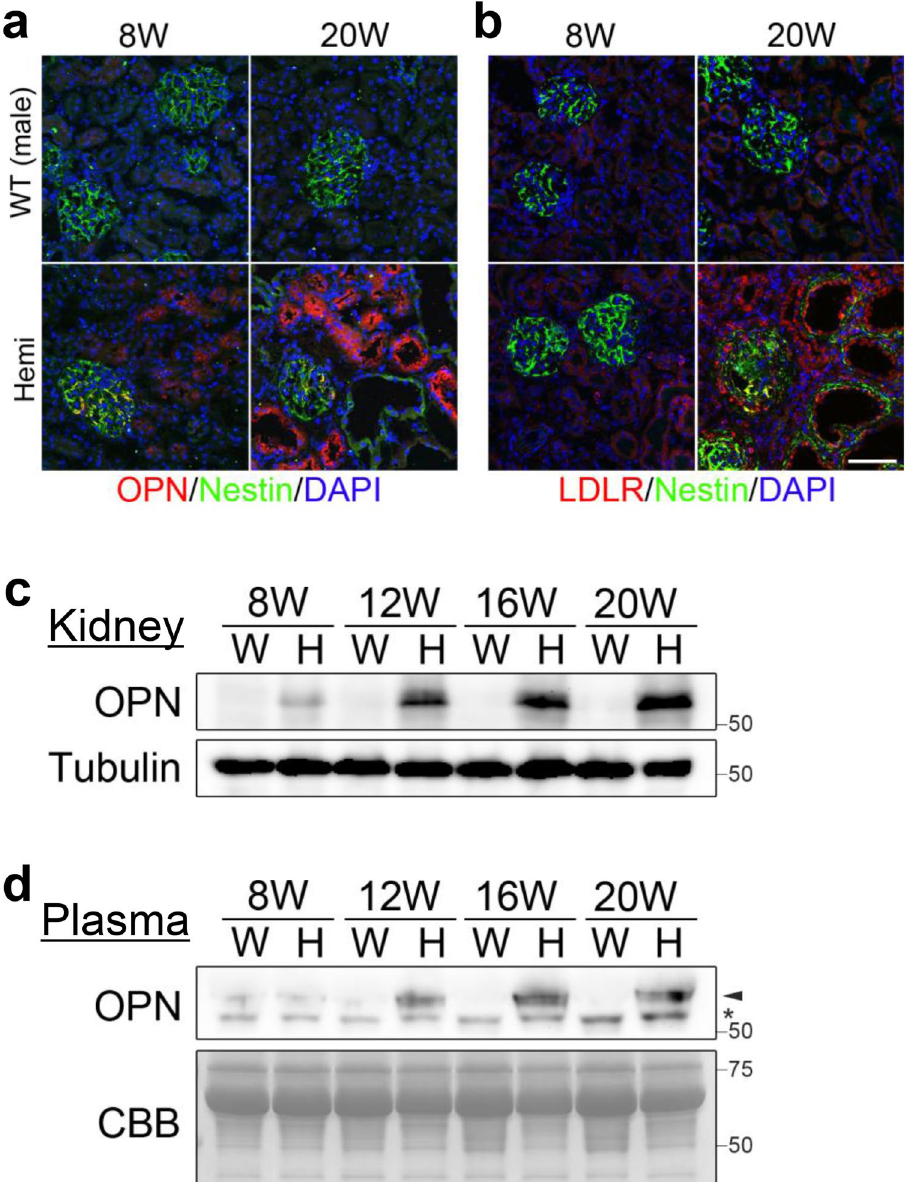
Figure 6. OPN and LDLR expressions in Col4 α 5 deficient rats. (a,b) Immunostaining of kidney sections with (a) OPN or (b) LDLR (red), Nestin (green; glomeruli), and DAPI (blue; nuclei) in wildtype (WT) and Col4α5 mutant (Hemi) male rats in wildtype (WT) and Col4α5 mutant (Hemi) male rats at 8 weeks (left) and 20 weeks (right) of age. Scale bars , 50 µm. (c,d) Detection of OPN by Western blotting of the kidneys (c) or plasma (d) in wildtype (W) and Col4α5 mutant (H) male rats from 8, 12, 16, to 20 weeks of age. Tubulin and CBB staining were evaluated as an internal control. Asterisk in (d) indicates non-specific